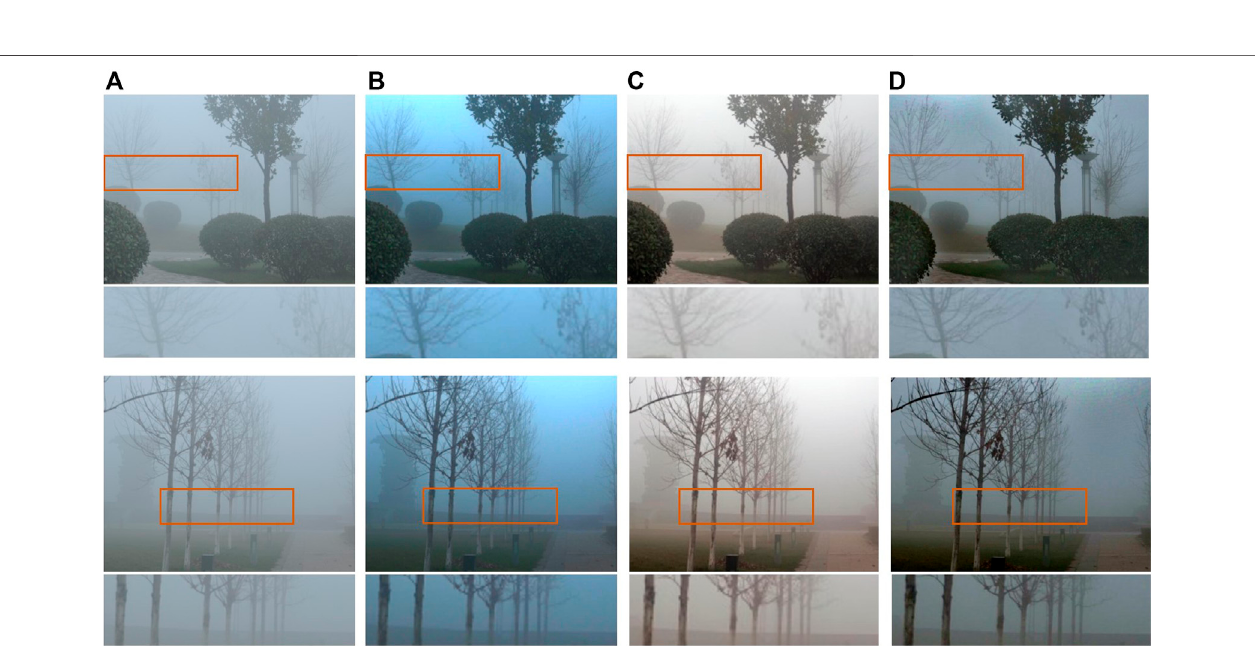
Frontiers in Physics |